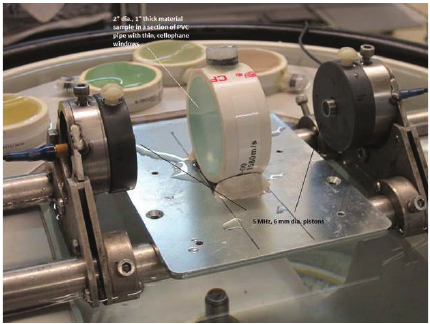
Figure3:Experimentalsetup.Two,colinear,5 MHz,6 mmdiameter piston transducers are mounted 100 mm apart. The 2 󸀠󸀠 diameter, 1 󸀠󸀠 thick material sample is placed between them normal to the beam